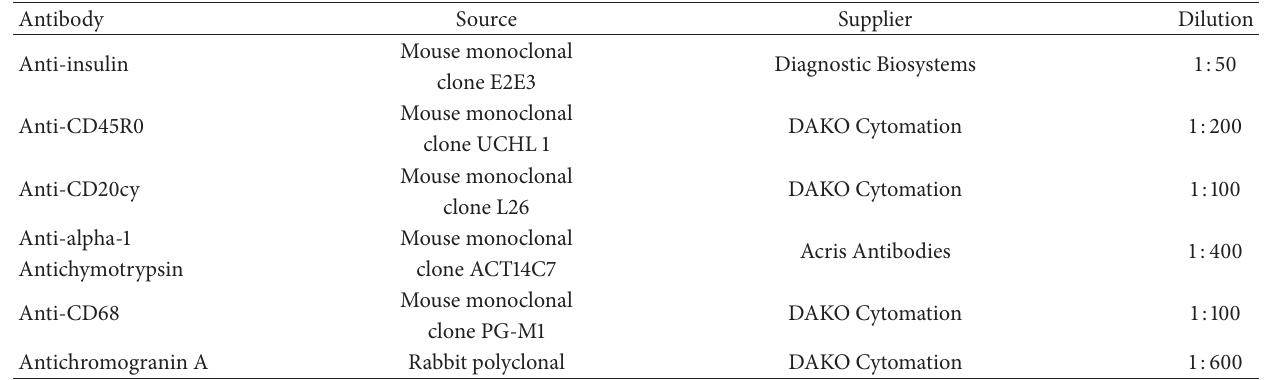
Table 1: Antibodies and their dilutions used in the study.